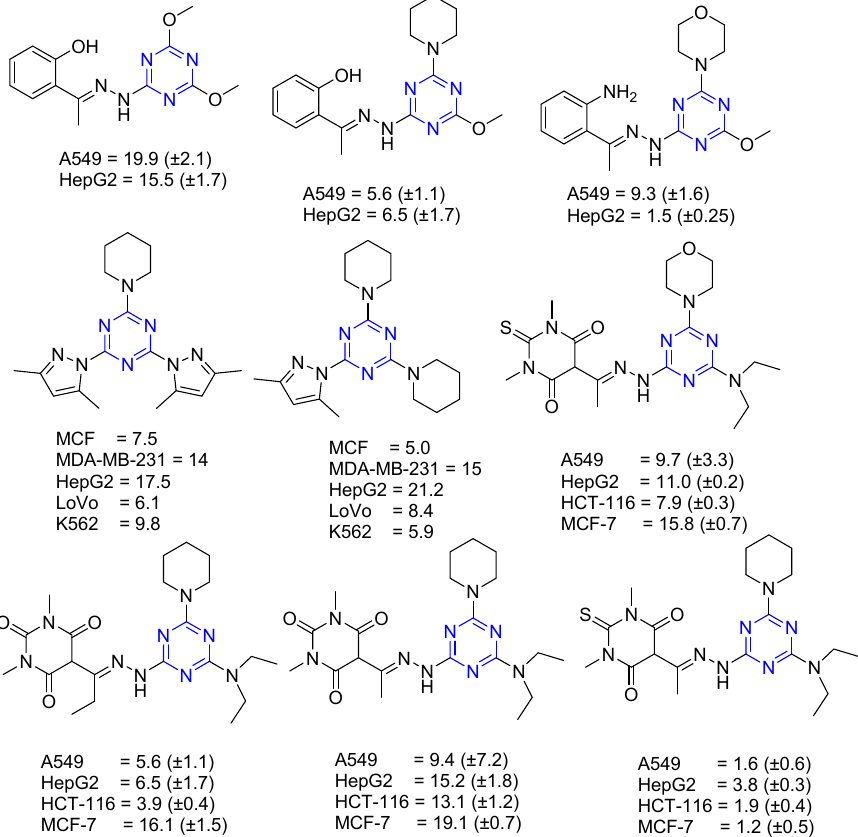
Figure 4. Compounds showing antiproliferative/anticancer activity (IC 50 ).